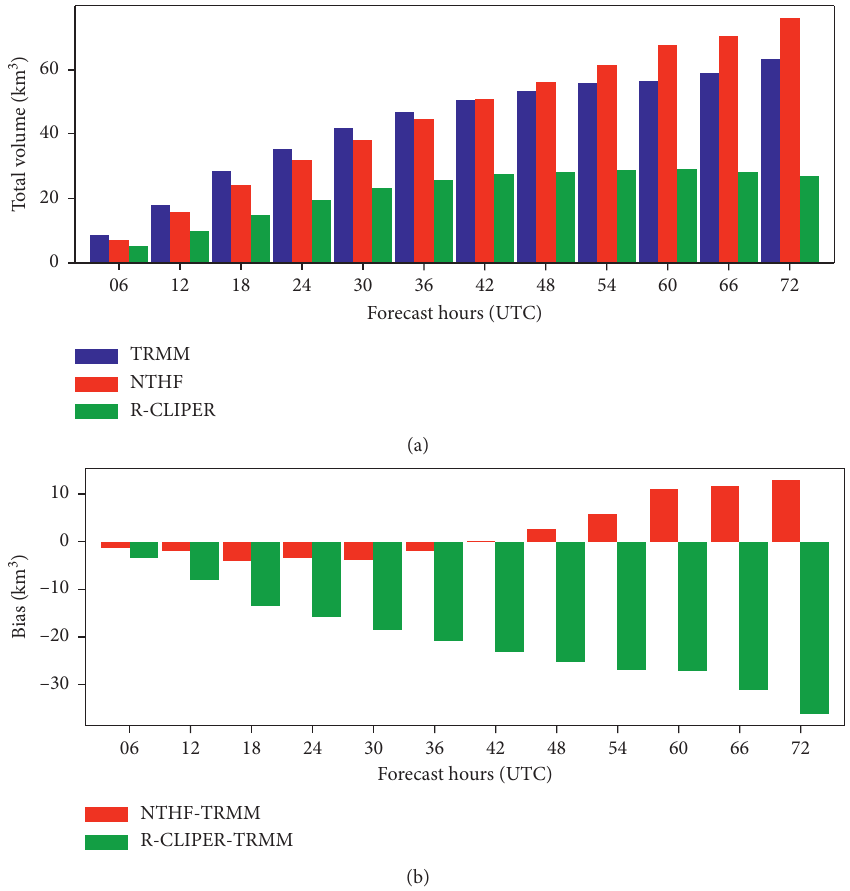
Figure 8: Total rain volume at different times. (a) Values determined from TRMM and calculated by NTHF and R-CLIPER. (b) Bias between system predictions and TRMM